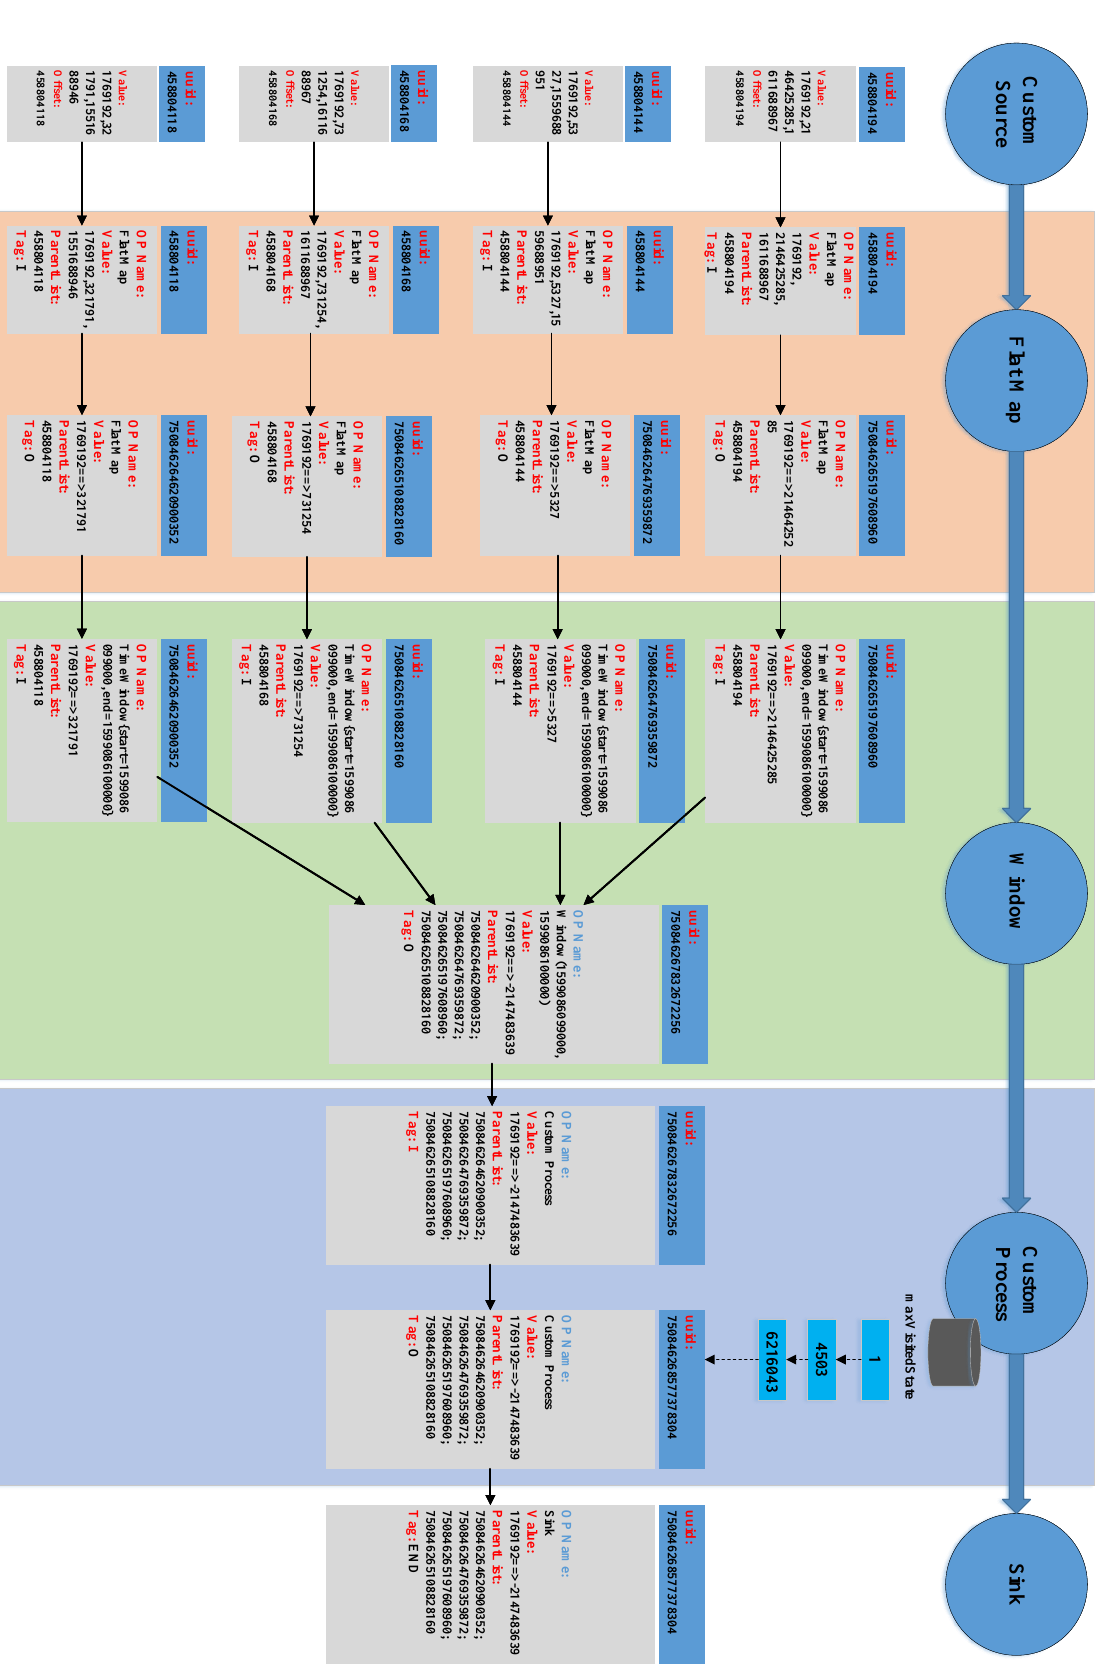
Figure 17. Data transformation and state transition for object data during the offline provenance